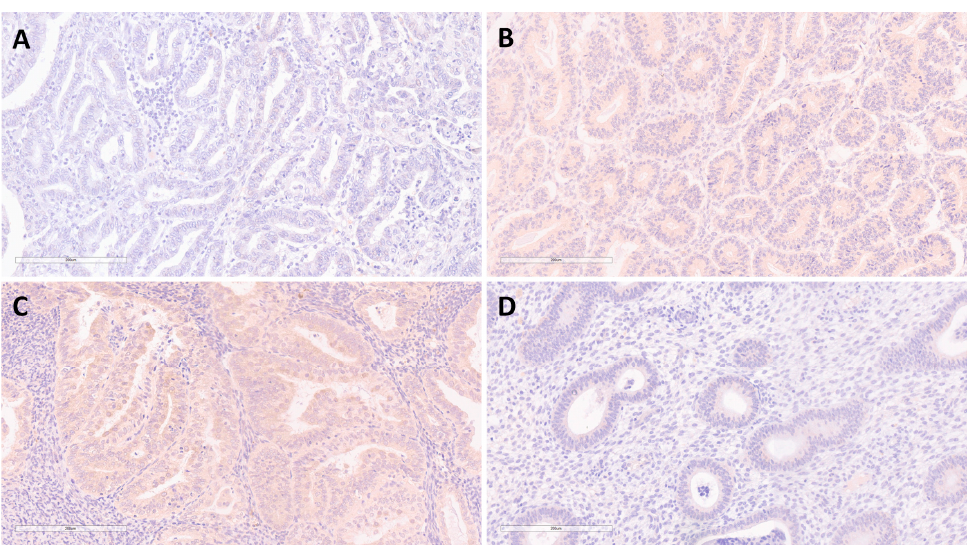
Figure 3. Immunohistochemical staining for VEGF-A in endometrioid endometrial carcinoma showing no expression—0 ( A ), low expression—1 ( B ), moderate expression—2 ( C ), and immunohistochemical staining for VEGF-A in benign endometrial hyperplasia showing no expression—0 ( D ). Magnification ×200.